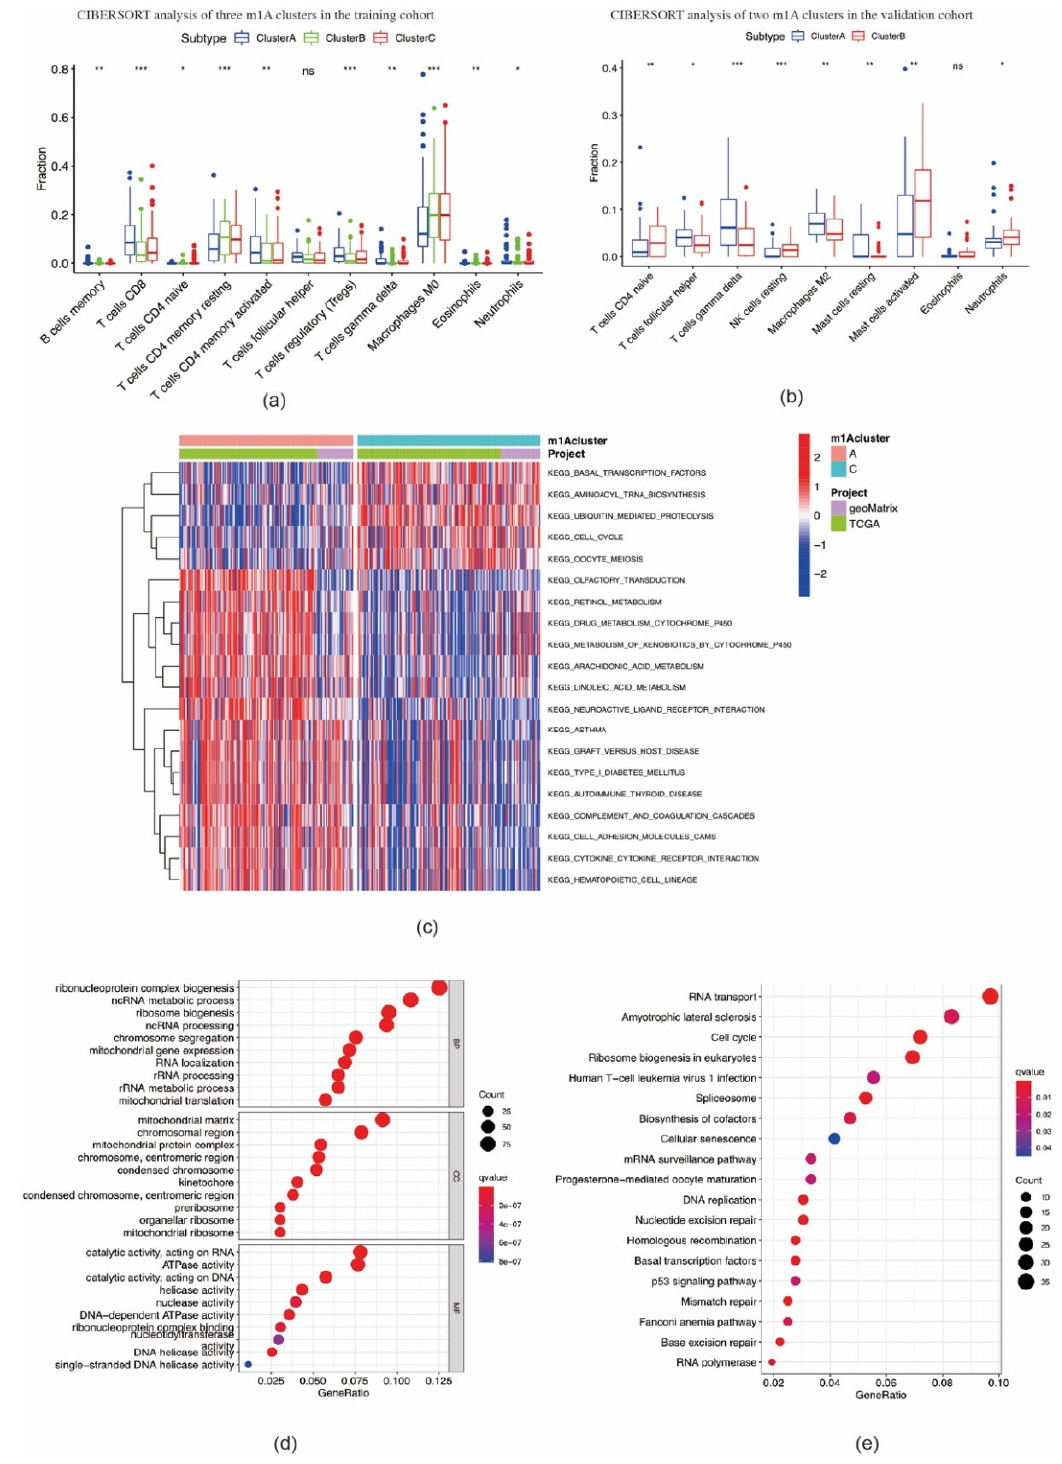
Figure 4. CIBERSORT analysis of m1A modification patterns and biological characteristics of m1A phenotype–related genes. ( a , b ) The fraction of tumor–infiltrating lymphocyte cells in m1A modification patterns in training cohort ( a ) and